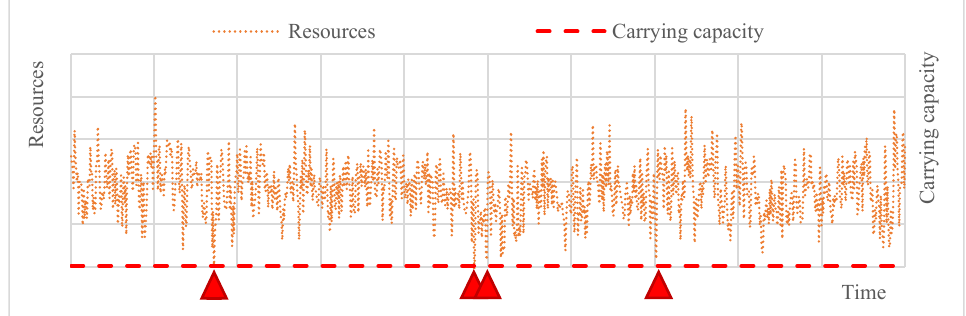
Figure 3. Toy model: The concept of environmental determinism with HK dynamics with H = 0.8. Outflows of the fountain follow Gaussian distribution. Red dash line shows the carrying capacity of the resources and red triangles show the phases of collapse.